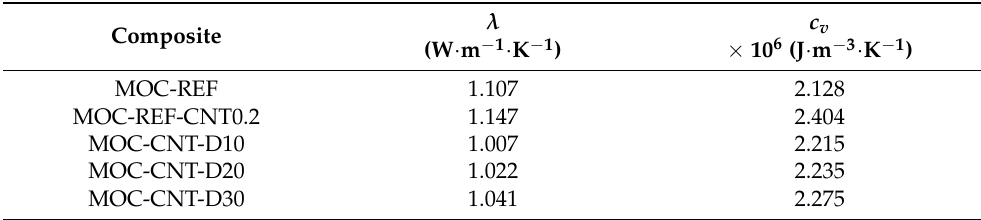
Table 5. Thermal properties of 28 days matured composites.